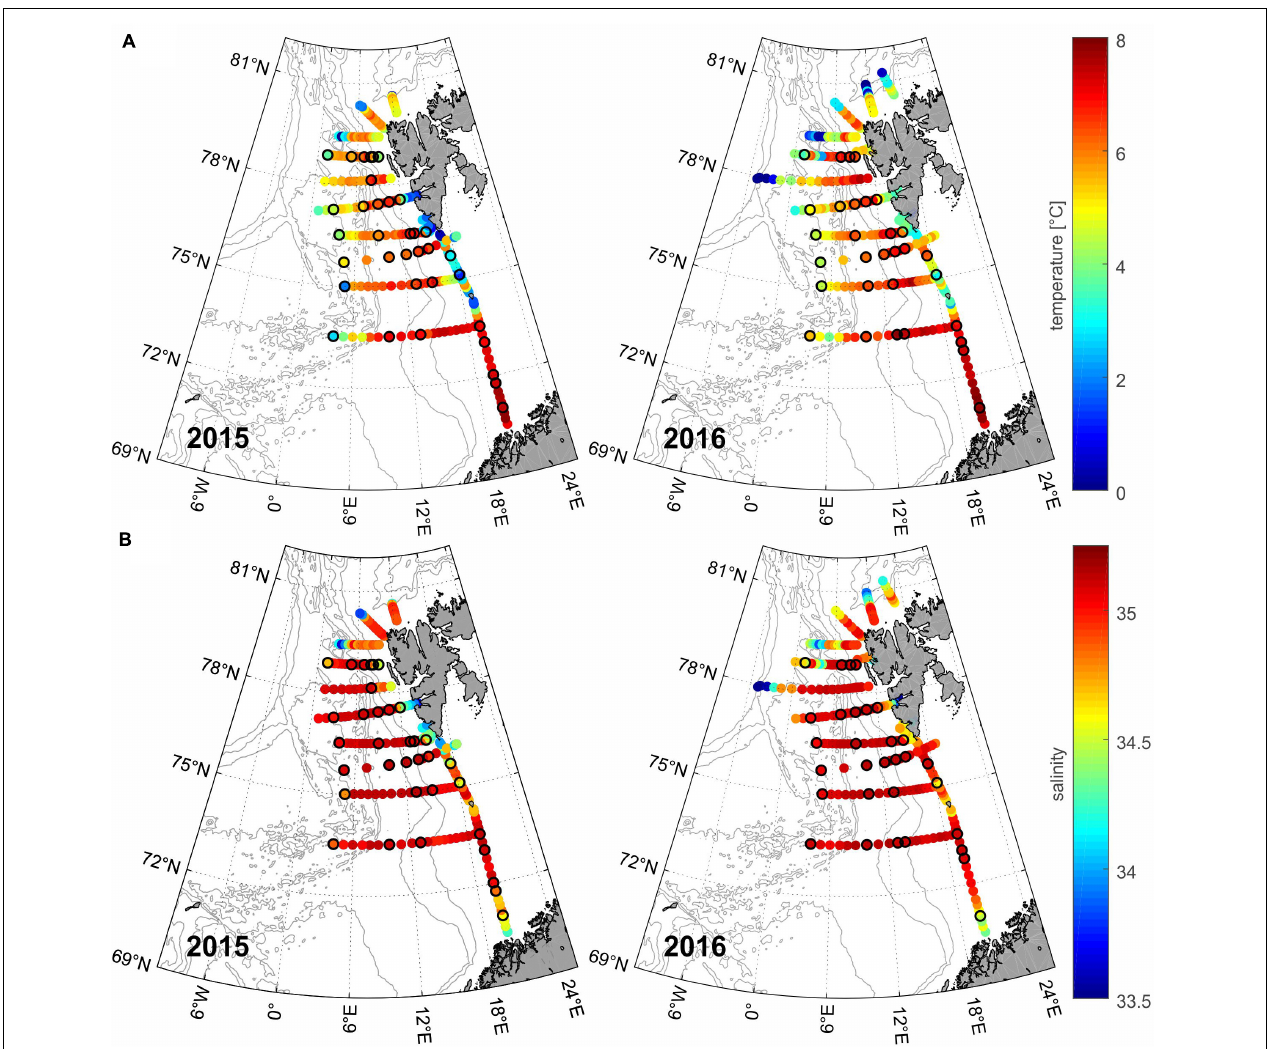
FIGURE 2 | Temperature [ ◦ C] (A) and salinity (B) of seawater (values averaged for the upper 50-m water column) in the area in 2015 and 2016. Colored circles correspond to the conductivity, temperature, depth (CTD) stations of the Arctic Experiment (AREX) cruises; circles with additional black frame indicate the plankton